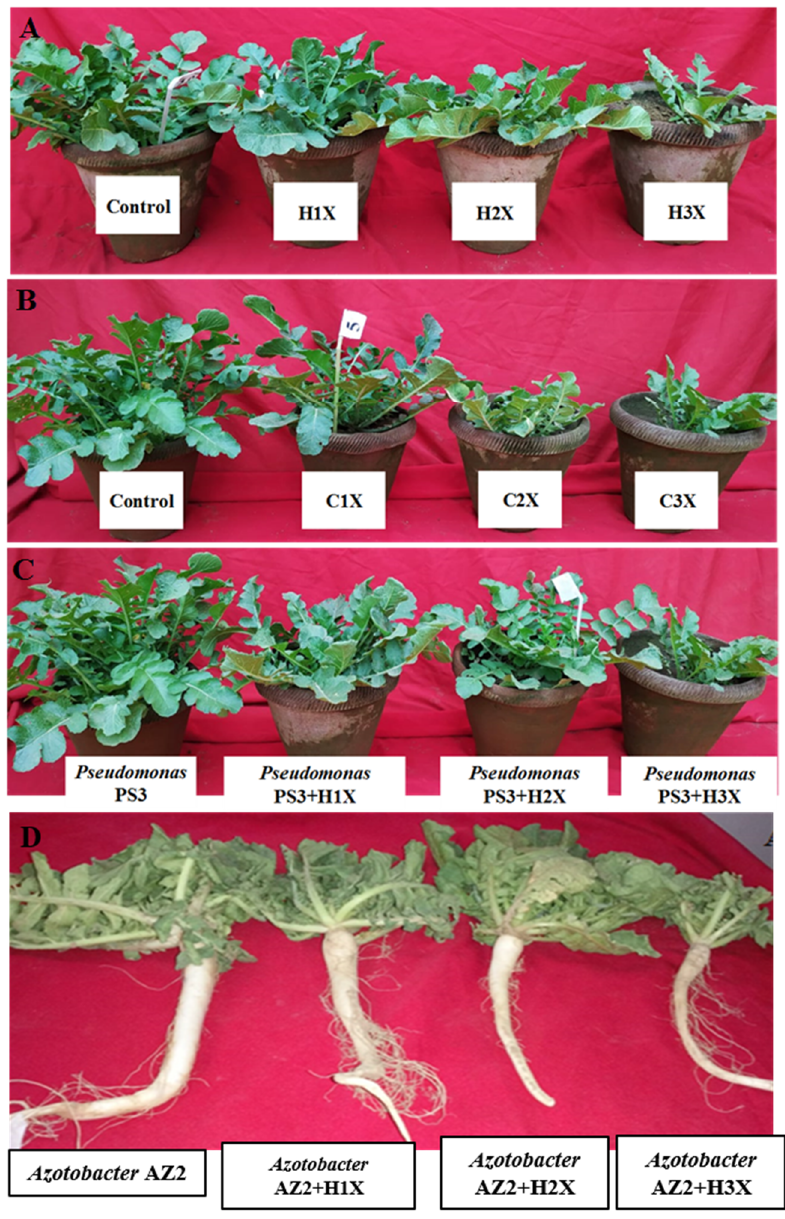
Figure 11. Effect of different concentrations of hexaconazole ( A ) and carbendazim ( B ) on growth of R. sativus grown in greenhouse conditions. Bioinoculation impact of Pseudomonas sp. PS3 on R. sativus grown in soil treated with 1X, 2X and 3X concentrations of hexaconazole ( C ). The panel ( D ) represent the roots system of R. sativus grown in soil treated with hexaconazole and inoculant AZ2. Here, H and C represent hexaconazole and carbendazim, respectively. The 1X, 2X and 3X represent the normal, two times greater and three times greater than normal application rate of fungicide.